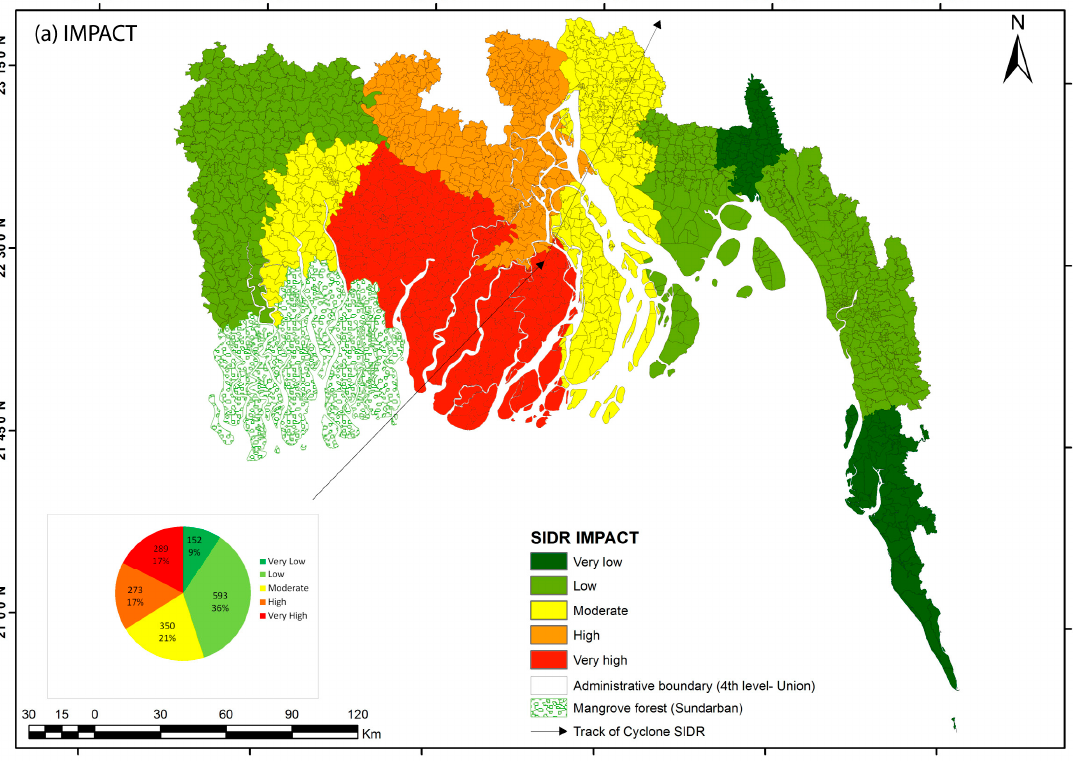
Figure 9. Cont. Figure 9.